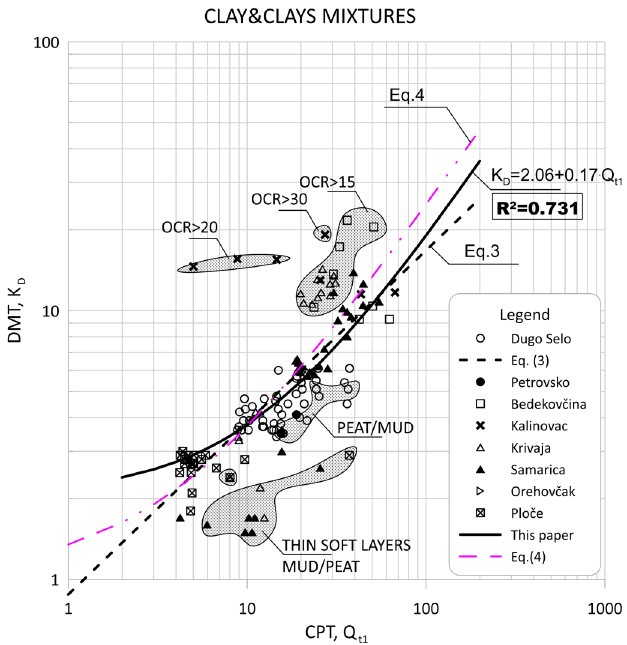
versus for 𝑄𝑄 𝑡𝑡1 𝐾𝐾 𝐷𝐷